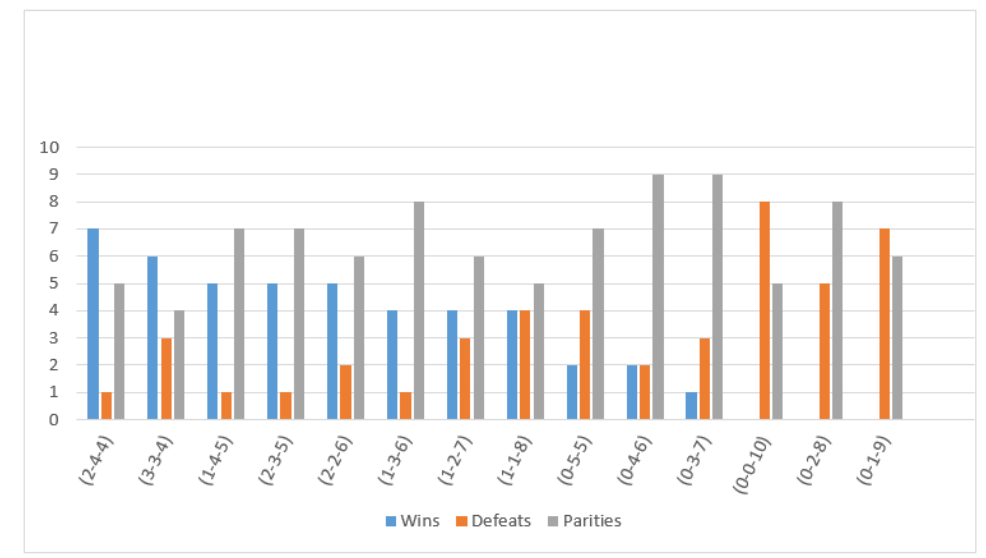
Figure 2. Graphical representation of the simulation result with homogeneous fields and